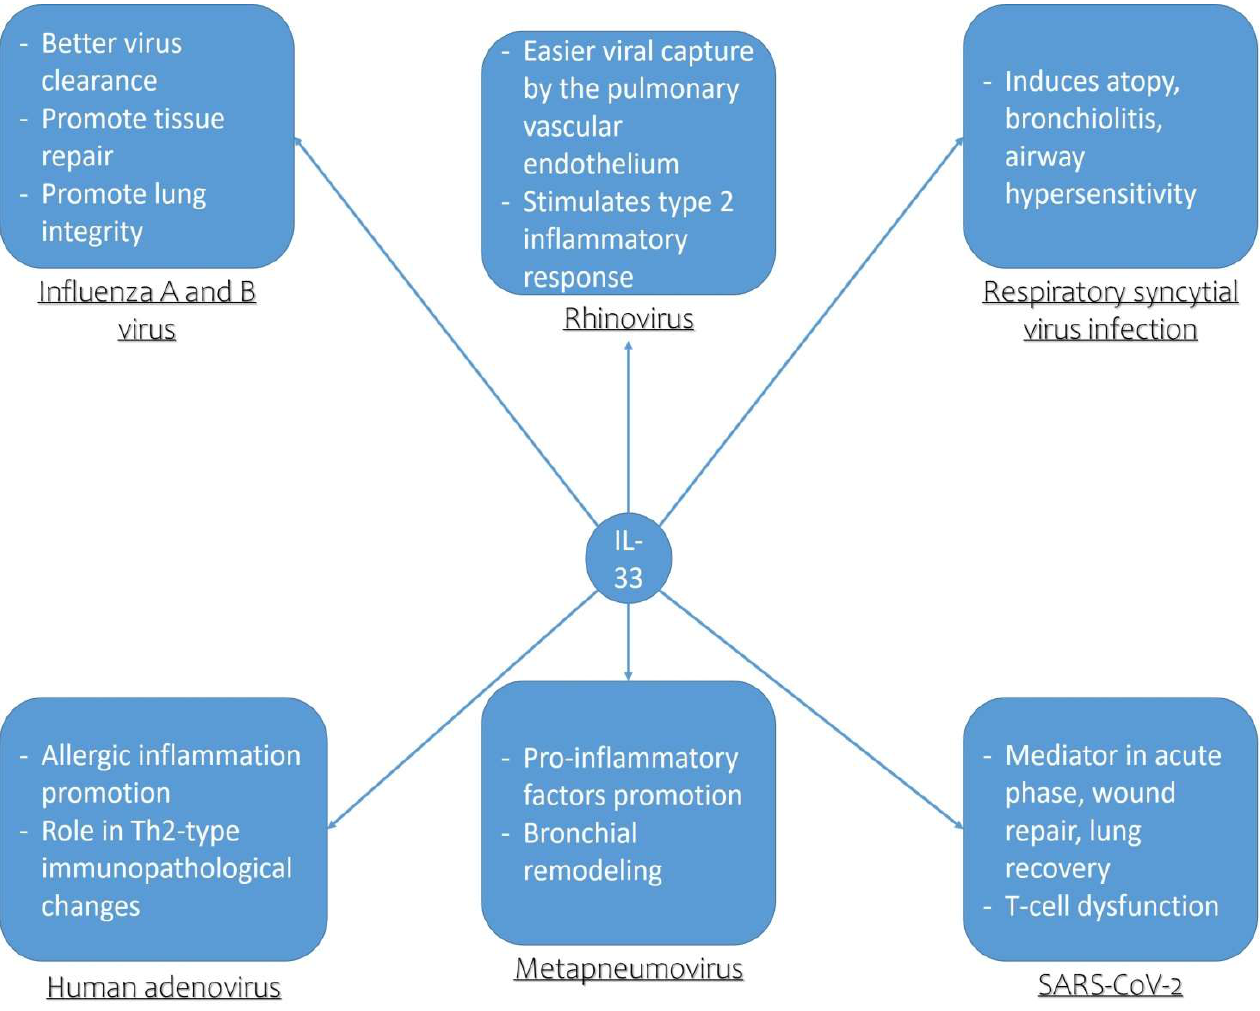
Figure 1. Pathogenetic role of IL-33 in respiratory viral infections.